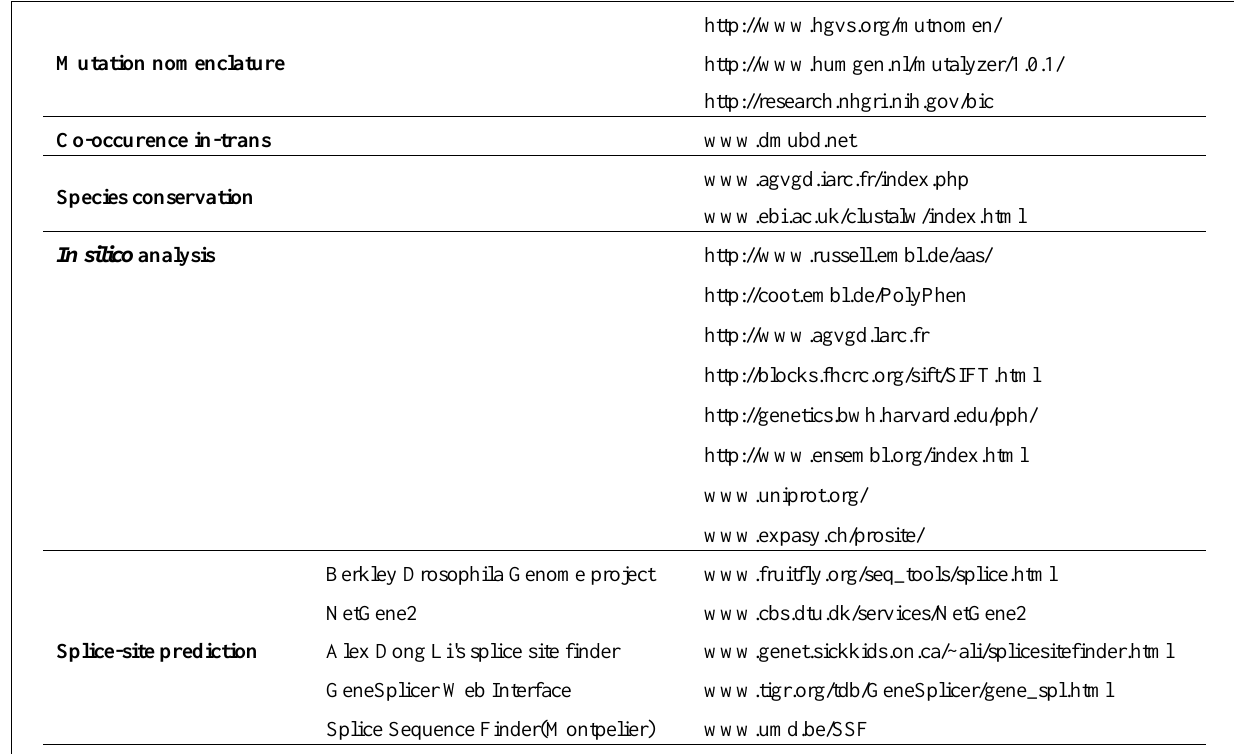
Table 1. International sites for variants of uncertain/unclassified significance (VUS)